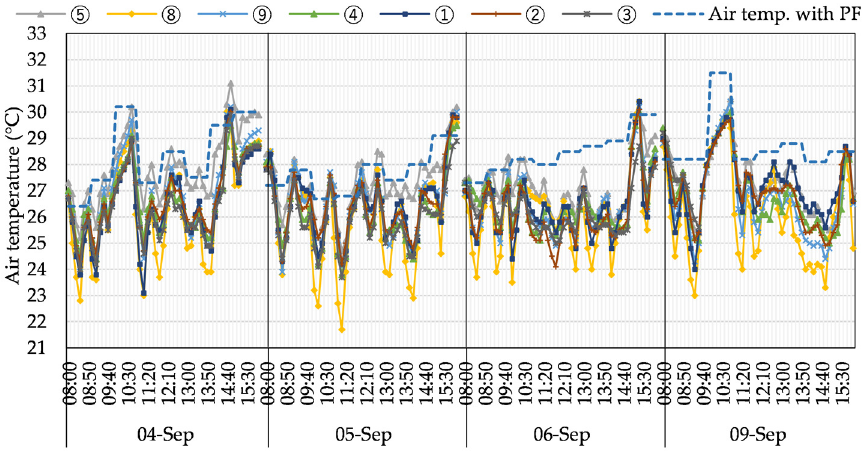
Figure 8. Summer air temperature for class A.